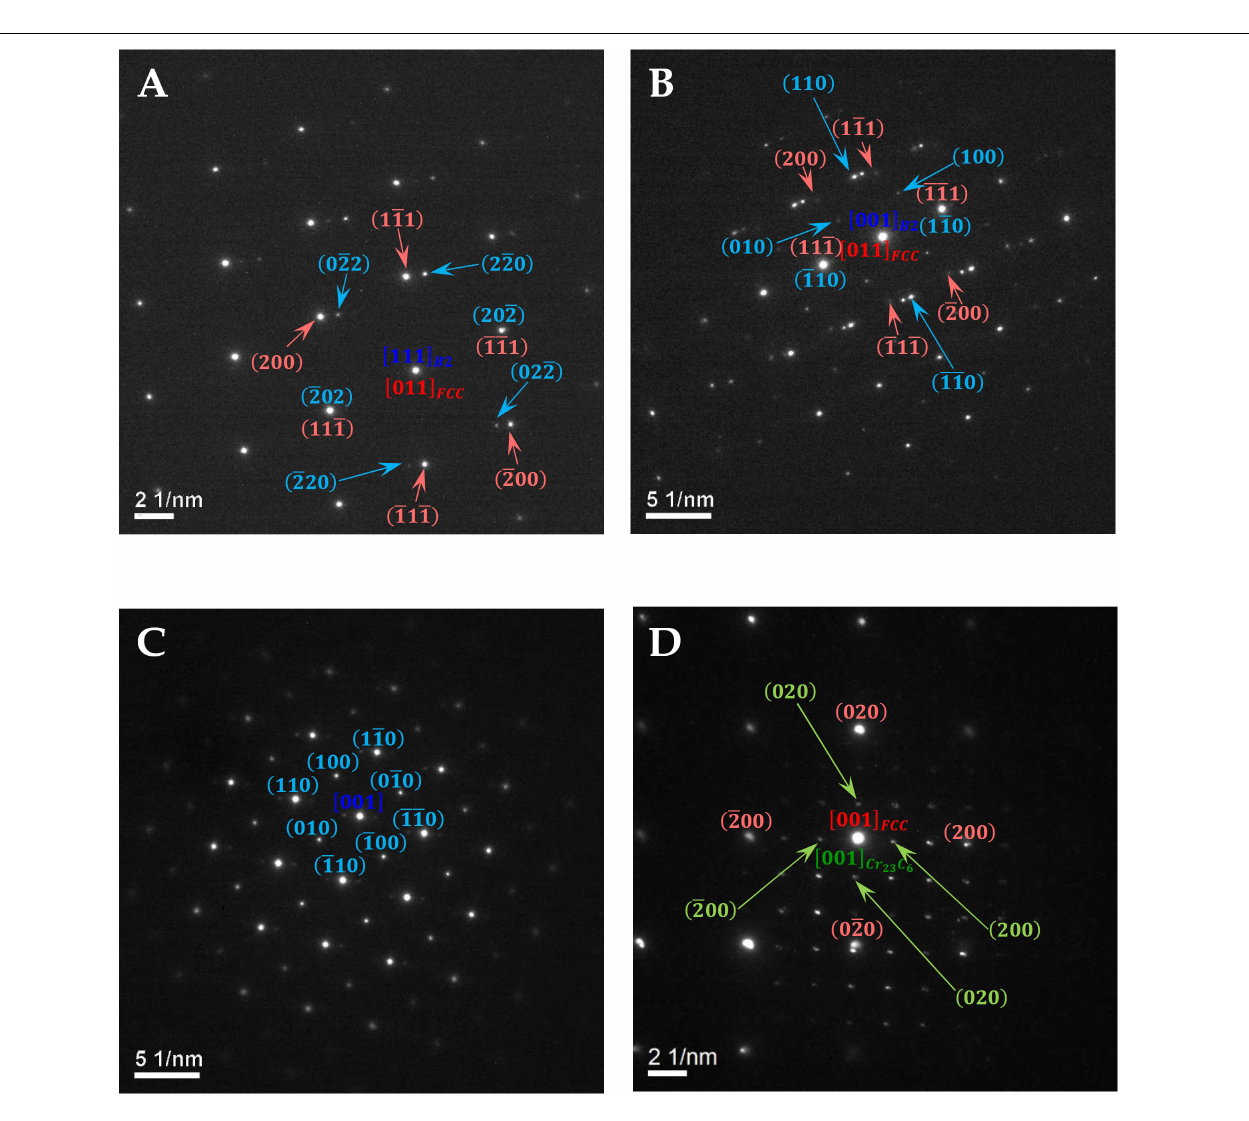
FIGURE 11 | SAED diffraction patterns in the homogenized and aged (750 ◦ C) AlCrFe 2 Ni 2 alloy – obtained from (A) a B2 platelet in Z.A. < 111 > inside the FCC phase in Z.A. < 110 > ; (B) a B2 platelet in Z.A. < 100 > inside the FCC phase in Z.A. < 110 > ; (C) the B2+BCC phase domain in Z.A. < 100 > ; (D) a M 23 C 6 particle bordering the FCC